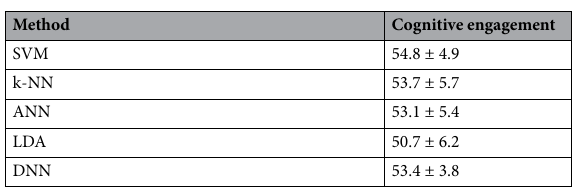
Table 2. Within-subject experimental results. Classification accuracies using the Engagement Index 25 for cognitive engagement classifications are reported. CNN classifier is not applicable since the Engagament Index consists in a single